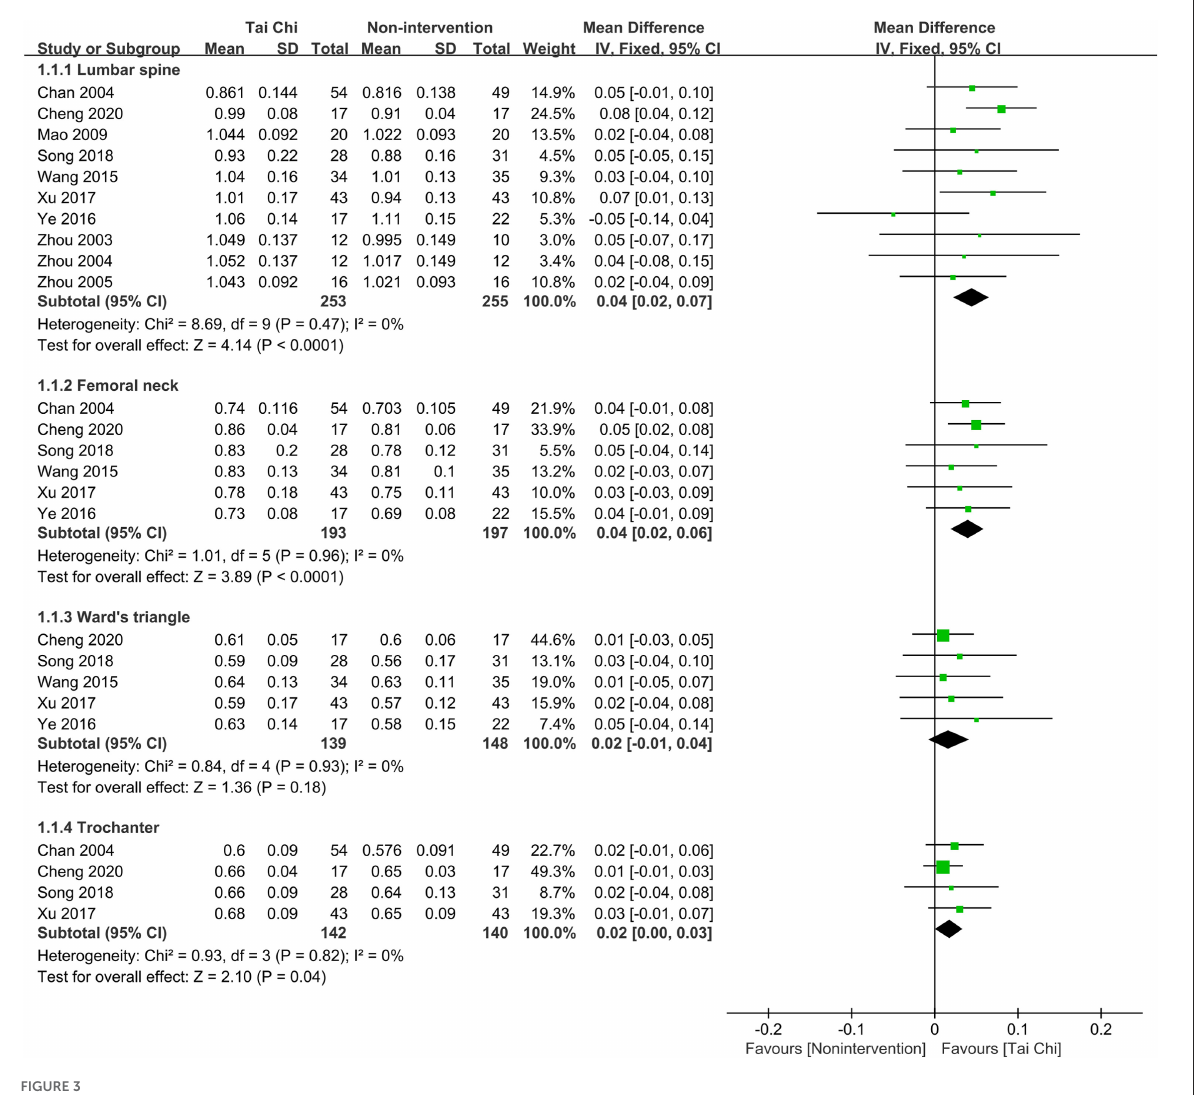
FIGURE3 Forest plot of meta-analysis results for Tai Chi vs.